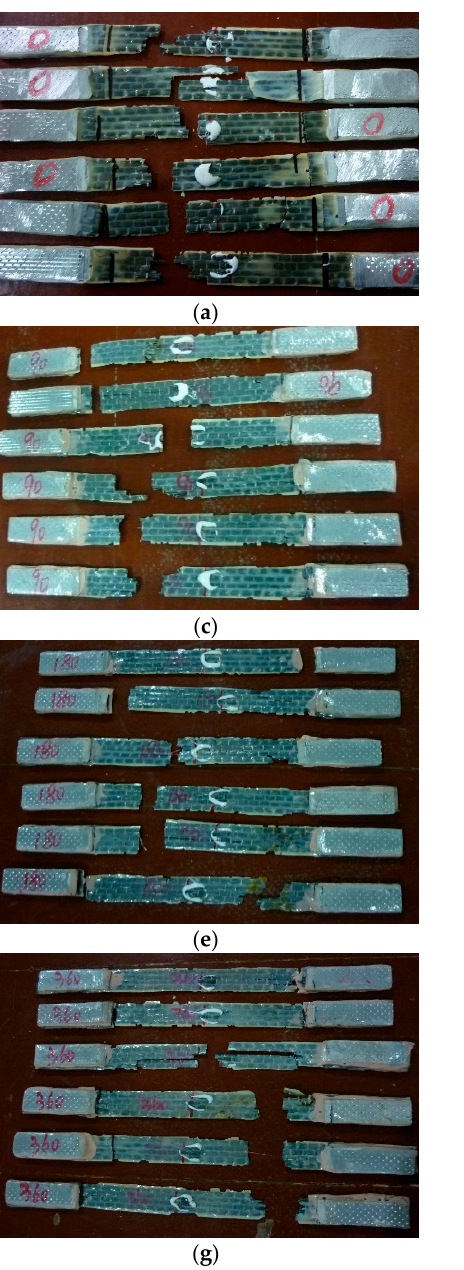
Figure 2. Typical failure modes of FRP samples: ( a ) CFRP-0, ( b ) GFRP-0, ( c ) CFRP-90, ( d ) GFRP-90, ( e ) CFRP-180, ( f ) GFRP-180, ( g ) CFRP-360, and ( h ) GFRP-360.